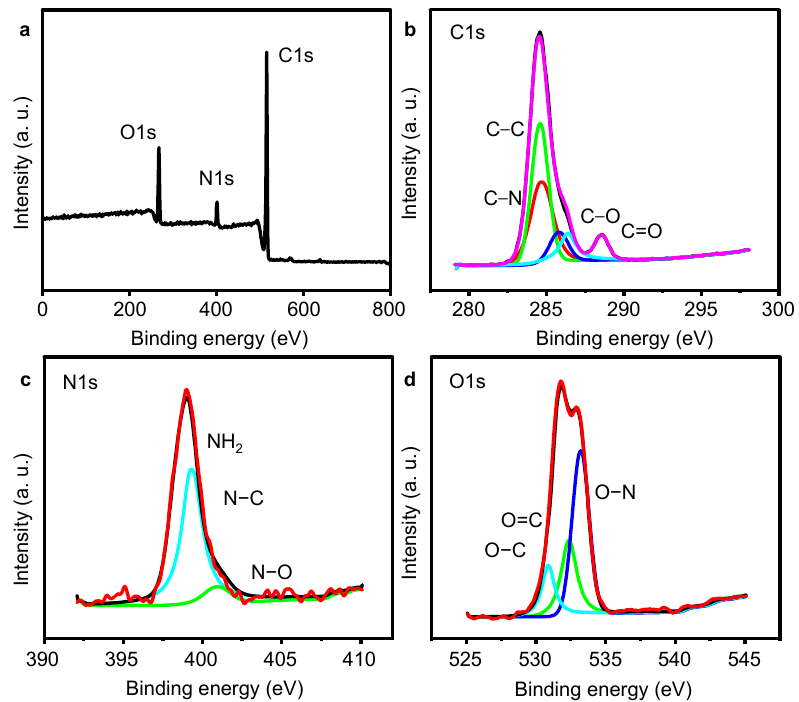
Figure 2. Structure characterization of N–GQDs: ( a ) XPS survey spectrum, ( b ) C1s, ( c ) N1s, and ( d ) O1s.